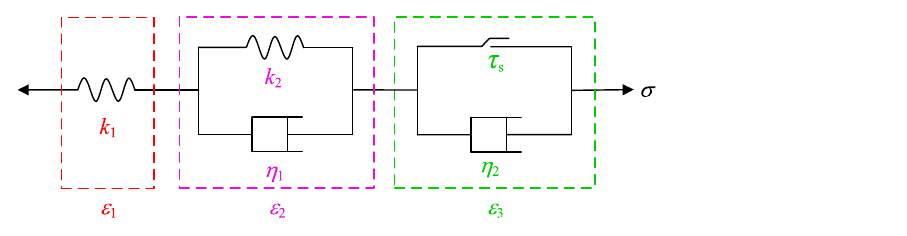
Figure 6. Nishihara model.